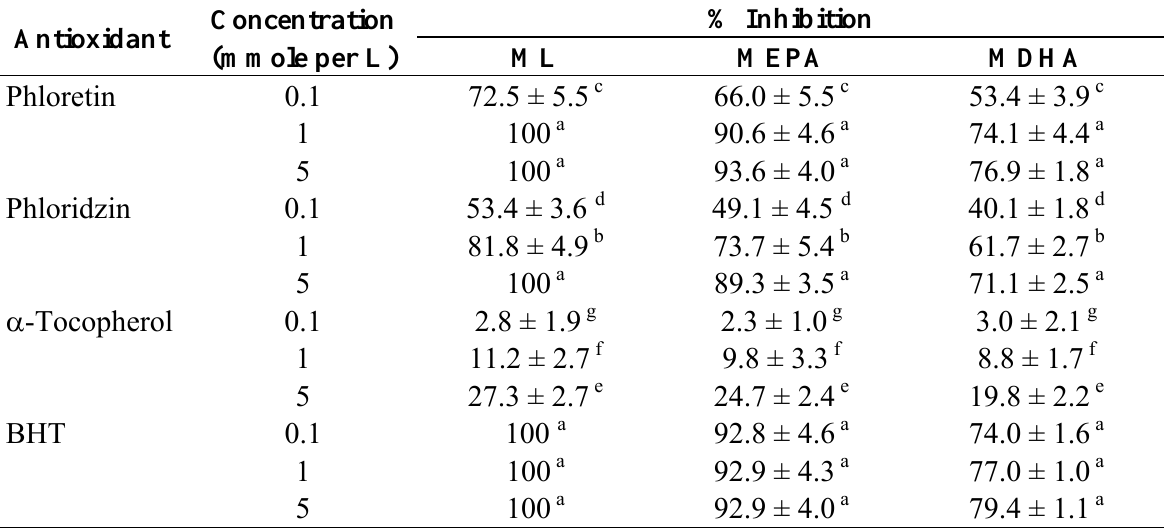
Data represent the mean (n = 6) of two individual experiments ± SD. Superscript in columns without letters in common differ significantly ( P <